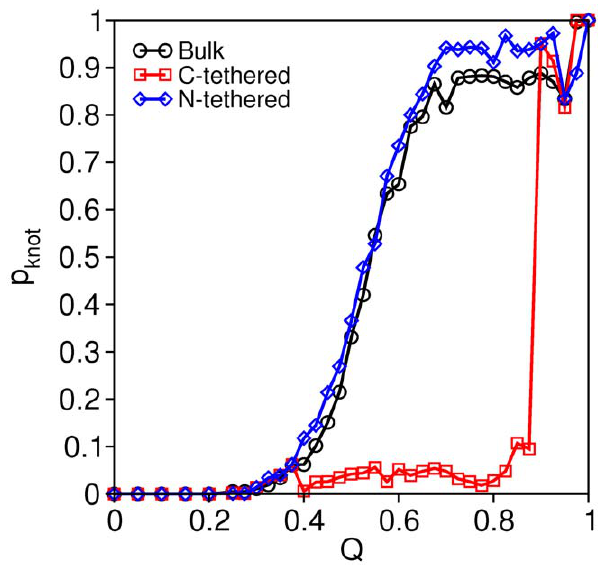
Figure 6. The probability to have the knot formed, p knot , as a function of the fraction of established native contacts Q in protein K at T m in the different folding setups.